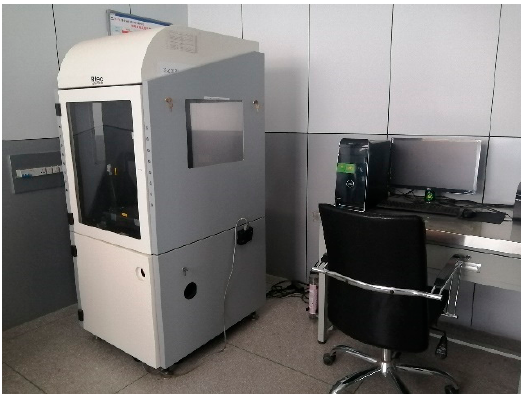
Figure 3. MFT-5000 friction and wear test bench. Table 3. Parameters of texture samples.